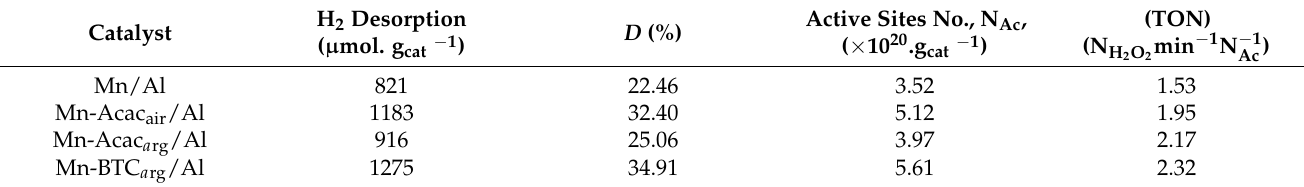
Table 3. The dispersion and number of manganese particles determined by H 2 -chemisorption of different prepared catalysts and the TON value of catalysts after 30 min.